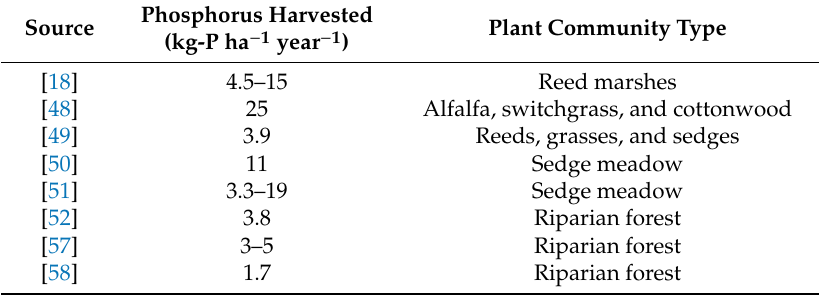
Table 3. Mean phosphorus mass removed from floodplains through vegetation harvest. Ranges reflect the range of means from multiple floodplains in the study listed.